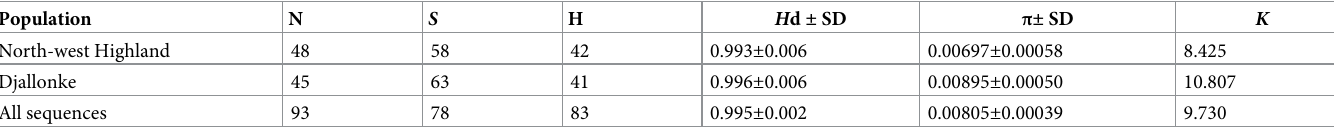
N = number of samples; S = number of segregating sites; H = number of haplotypes detected; H d = haplotype diversity; SD = standard deviation; π = nucleotide diversity; K = average number of nucleotide